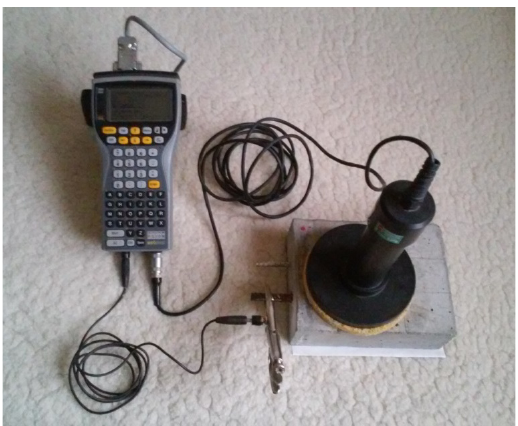
Figure 3. The connection scheme of the GP-5000 GalvaPulse TM set with the tested reinforcement.